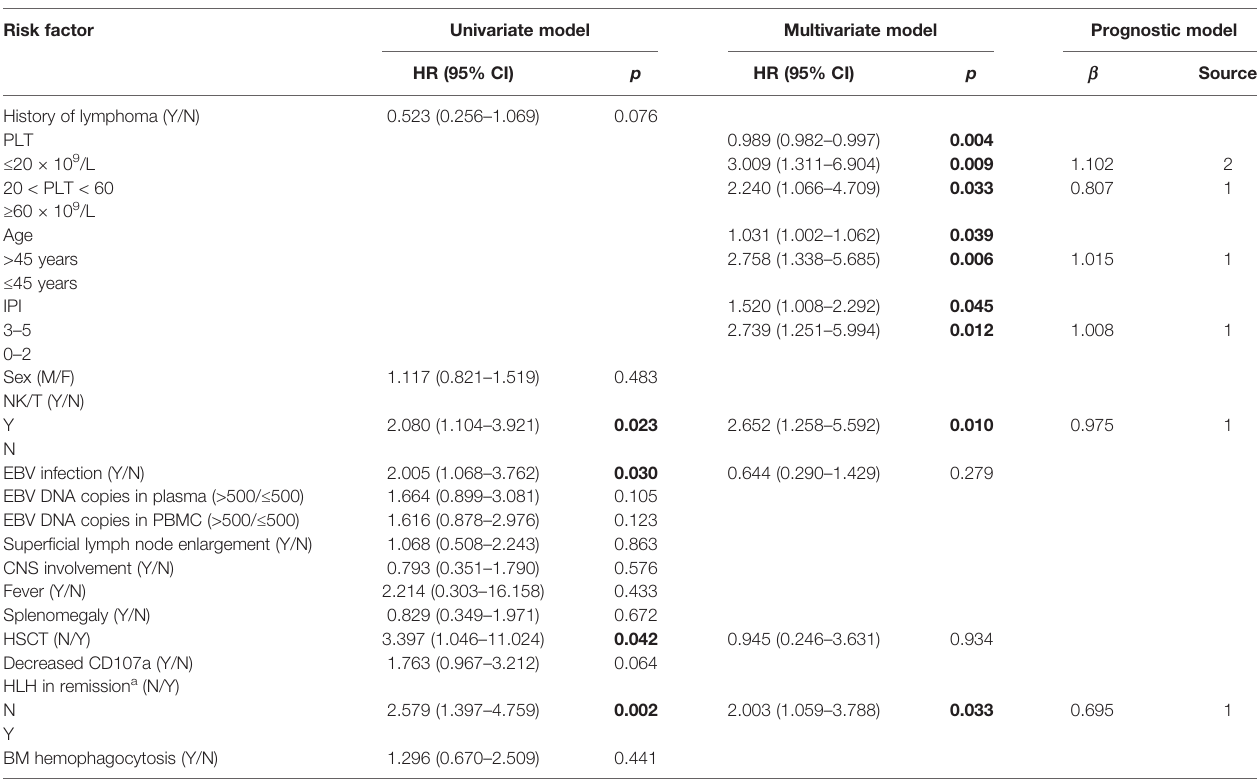
TABLE 3 | Cox regression analysis of prognostic risk